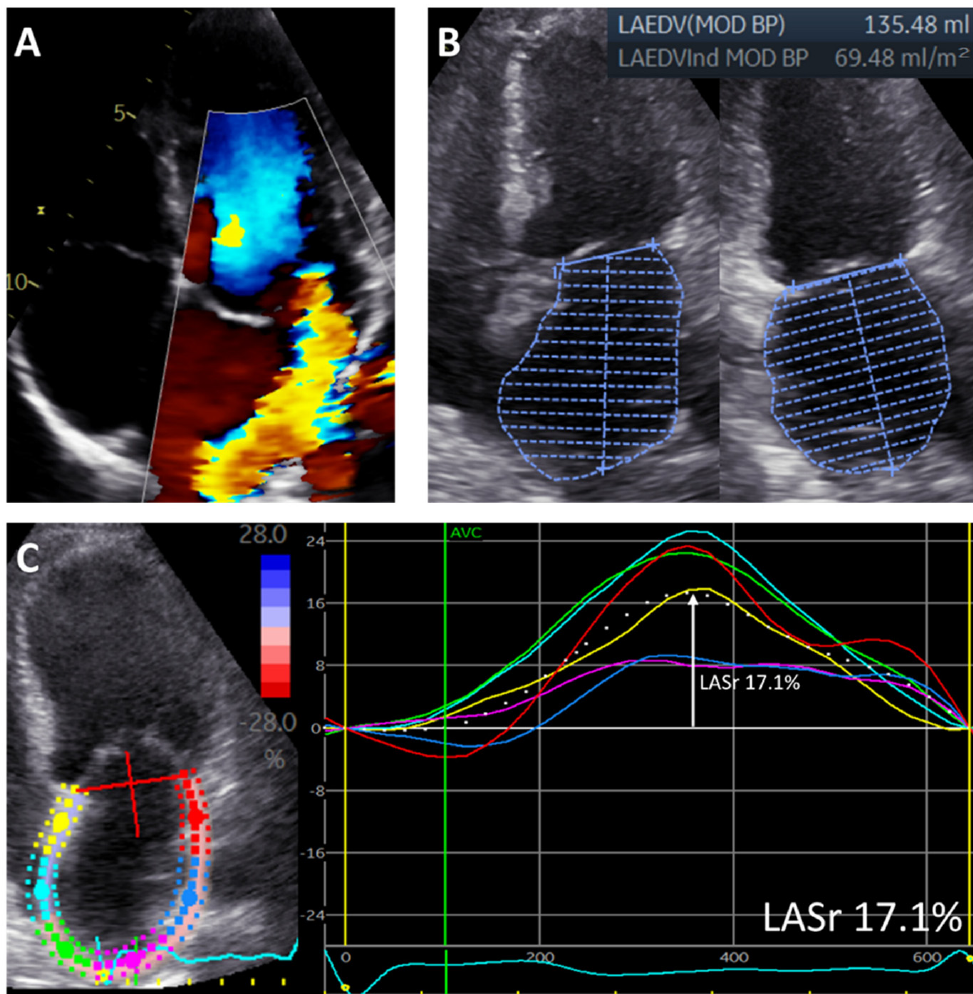
Figure 1. Measurements of left atrial volume and left atrial reservoir strain in a patient with significant primary mitral regurgitation. The figure shows a patient with significant primary MR ( A ) who had an enlarged LAVi (measured according to the biplane Simpson method) ( B ) and reduced LASr (measured as the peak value from the LA strain versus time curve derived from the 4-chamber view) ( C ). Regional strain curves are represented by different colors (yellow, red, blue, pink, green, light